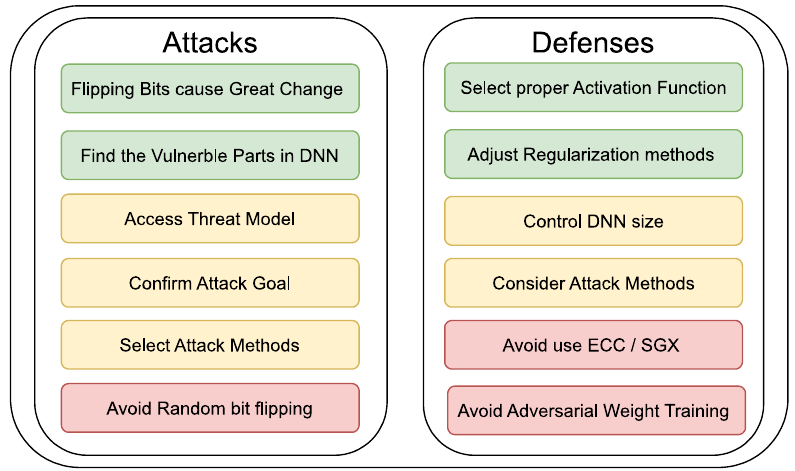
Figure 13. Findings based on existing